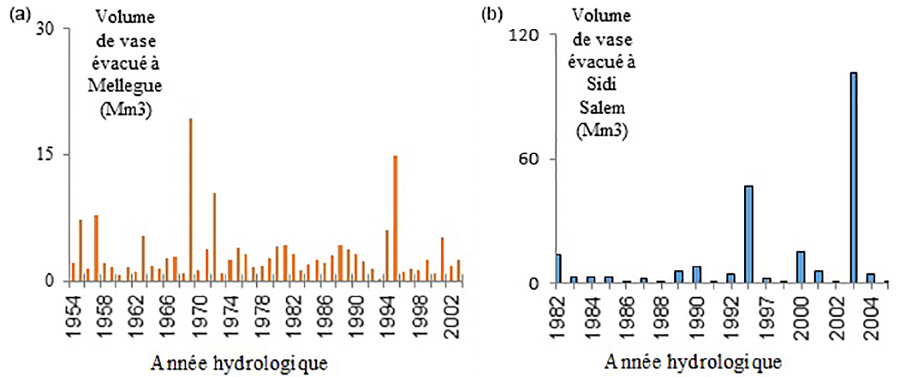
Figure 2. (a) Le volume de vase évacué au niveau du barrage Mellegue entre 1954 et 2003. (b) Le volume de vase évacué au niveau du barrage Sidi Salem entre 1982 et